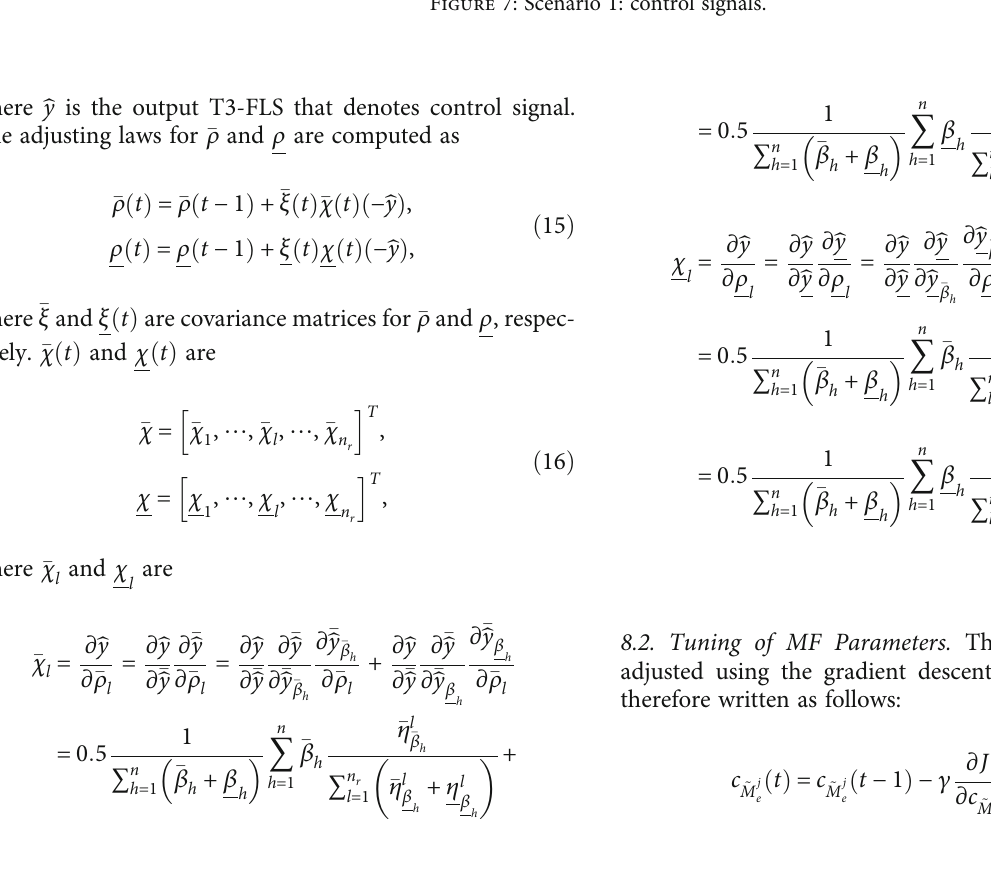
Figure 7: Scenario 1: control